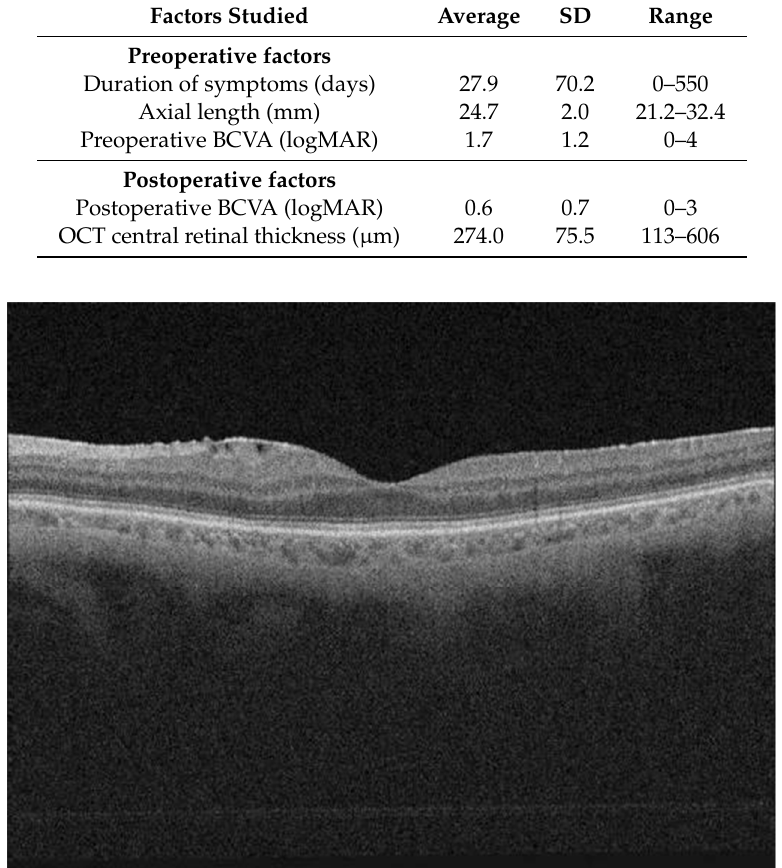
Figure 1. Postoperative optical coherence tomography (OCT) scan of a patient showing a well restored ellipsoid zone (EZ); the scan is showing also the epiretinal membrane.